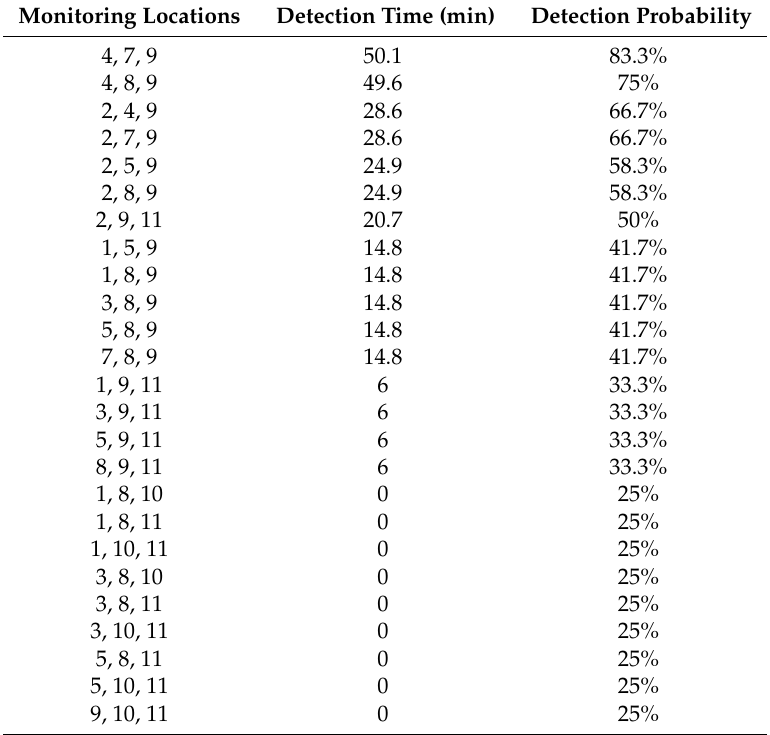
Table 7. Pollution detection time and pollution detection probability in Pareto frontier with a detection threshold of 2